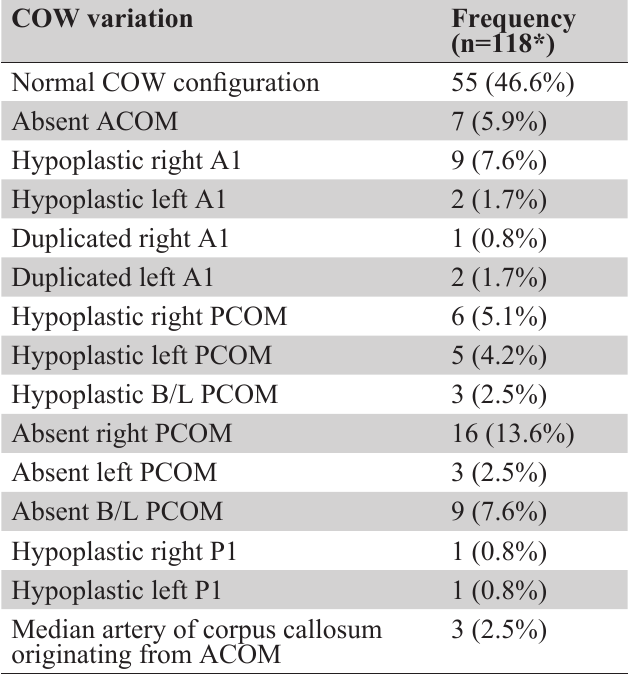
Figure 5. Absent B/L PCOM (Arrows). Table 1. Frequency of COW